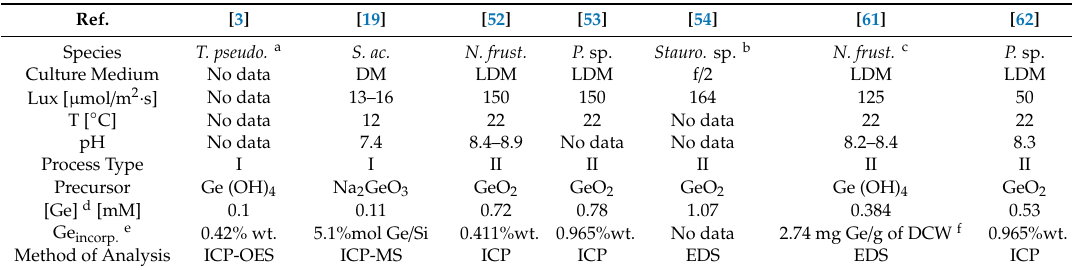
Table 3. Comparison of the applied conditions for diatoms culture and the degree of germanium incorporation into diatomaceous biosilica.